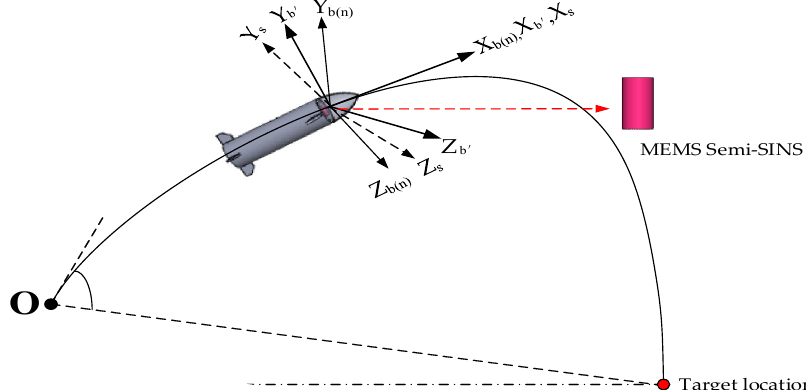
Figure 3. Definition of coordinate systems. Legend: MEMS, micro-electro-mechanical system.